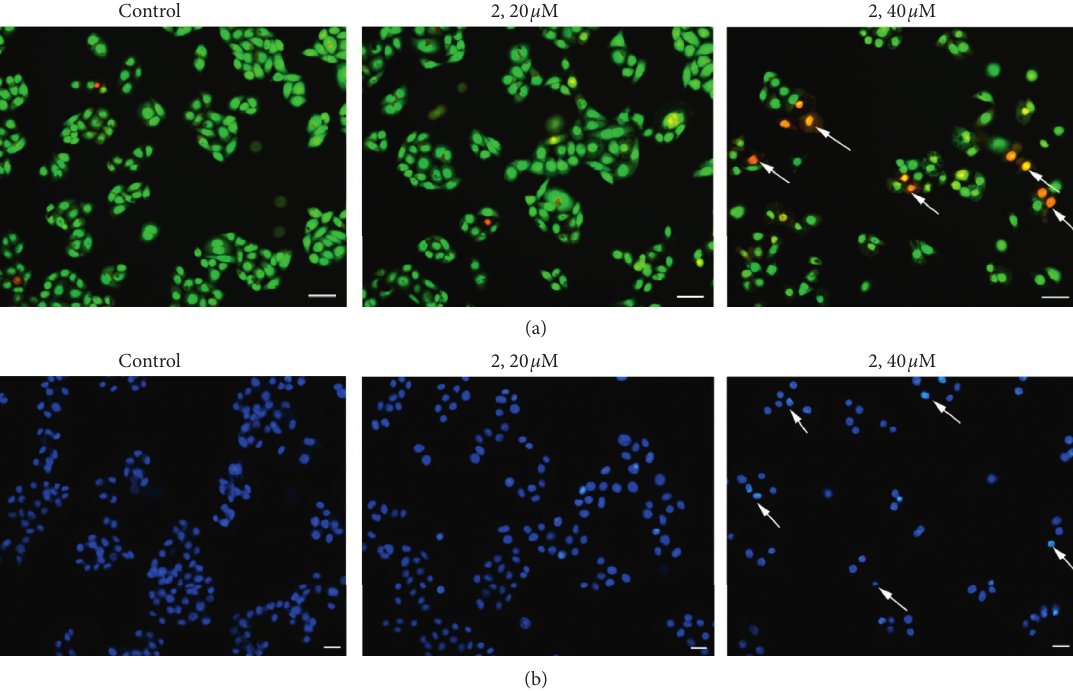
Figure 3: Eca-109 cells were stained with AO/EB (a) and Hoechst 33342 (b) after being exposed to complex 2 (0, 20, and 40 μ M) for 24h under a fluorescence microscope. Representative photomicrographs from three independent experiments. Arrows indicate apoptotic bodies. Scale bars: 20 µ